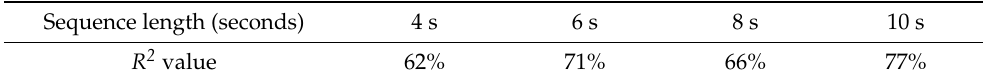
Figure 6. Training results: ( a ) training and validation mean square error (MSE) loss graphs for each epoch and ( b ) actual and predicted MD errors. Table 2. R 2 value for different sequence